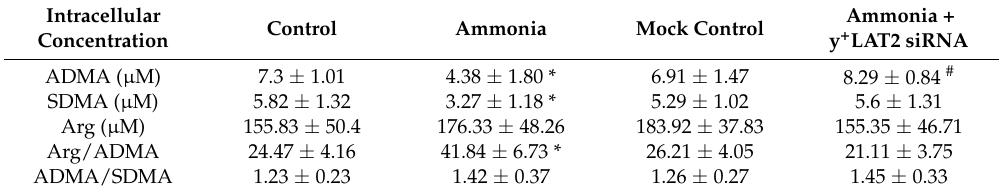
Table 1. Intracellular ADMA/SDMA/arginine (Arg) concentrations in ammonia-treated astrocytes and effect of Slc7a6 gene silencing. Results are mean ± SD; n = 8 (control; ammonia) n = 4 (Mock control; ammonia + y + LAT2 siRNA); * p < 0.05 vs. respective control; # p < 0.05 vs. ammonia.